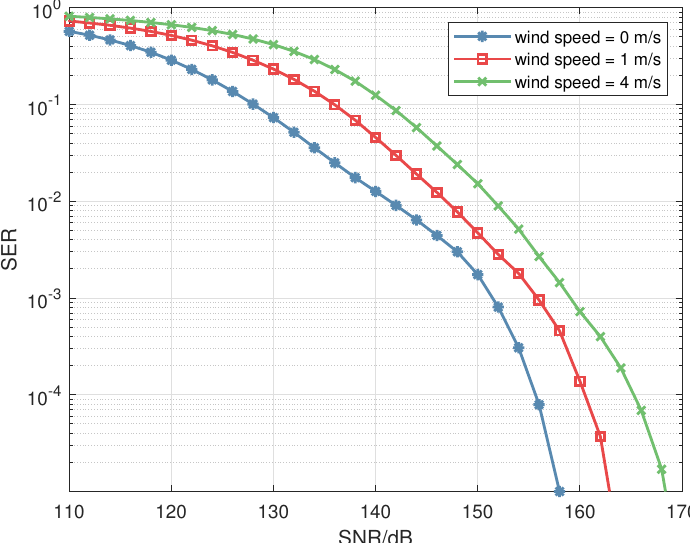
Figure 11. Comparisons with different wind speeds for the air–water interface